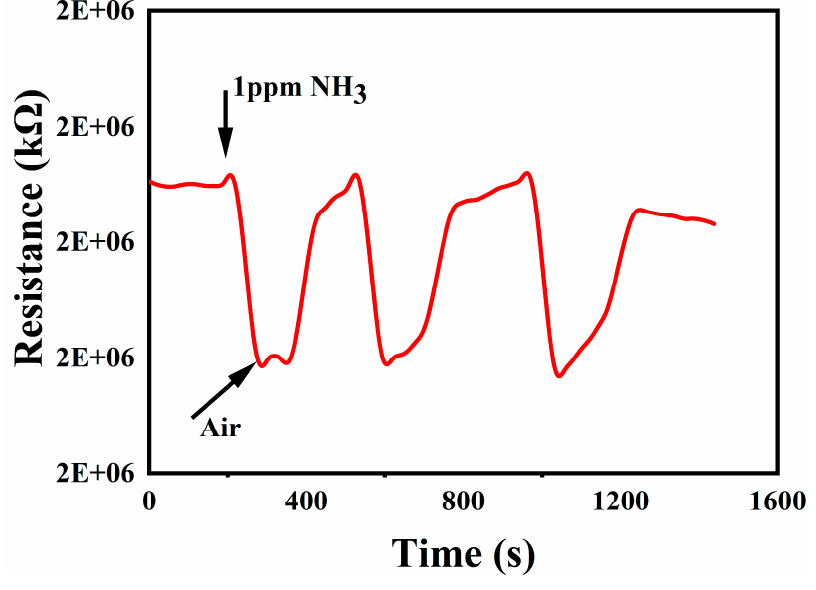
Figure 8. Repeatability test of S-1.